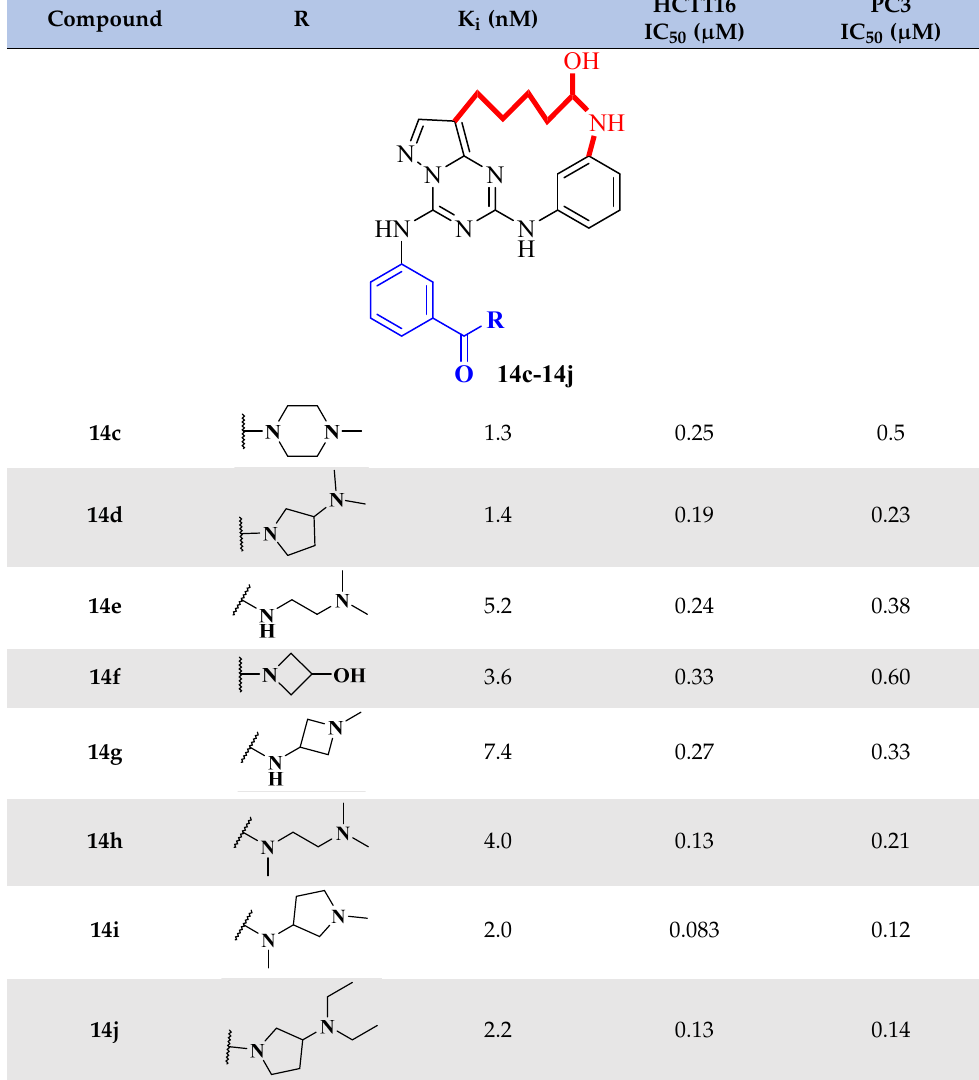
Table 5. In vitro cytotoxic activity of macrocyclic pyrazolotriazines 14c ~ 14j [43]. Compound